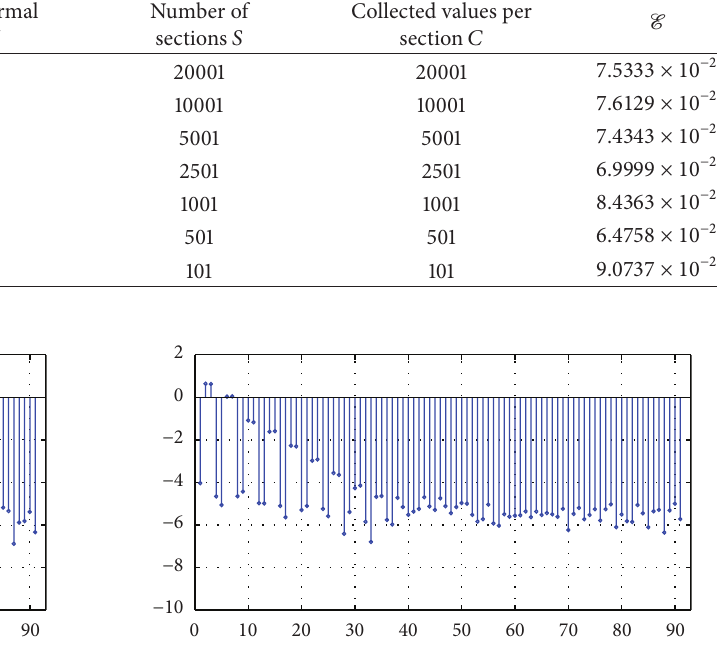
Figure 7: Absolute values of the coefficients 𝛼 𝑛 employed for approaching the boundary condition 𝑢| Γ = 𝑒 −𝑥𝑦 , utilizing the base elements {𝑢 𝑛 } corresponding to the conductivity function 𝜎 = 𝑒 𝑥𝑦 .